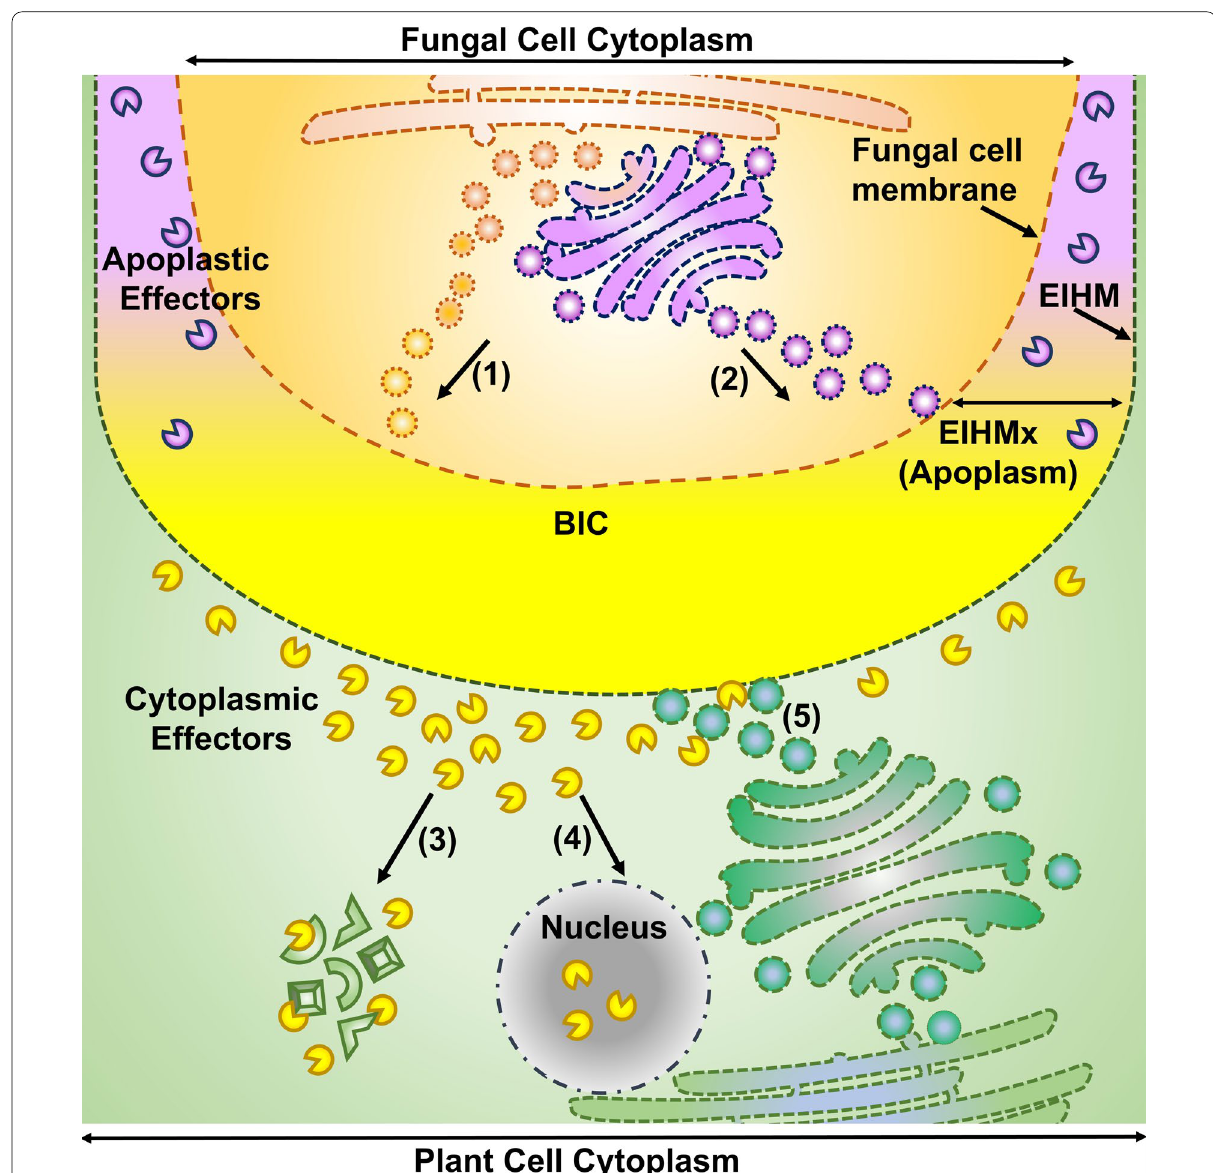
Fig. 3 Effector secretory routes of M. oryzae . The fungal effector secretion takes place via vesicles and follows two routes. The BFA-insensitive vesicle secretion from endoplasmic reticulum (ER) which forms the BIC (1), which is destined for the plant cell cytoplasm, and the BFA-sensitive effector secretion, via Golgi apparatus, which is directed to the EIHMx (2). The effectors secreted to the EIHMx are the apoplastic effectors (violet pie shapes) and secretions from BIC are the cytoplasmic effectors (yellow pie shapes). The cytoplasmic effectors further localise to specific cell compartments such as the nucleus or plasmodesmata (3) or bind their target proteins (4), or have enzymatic activity, to compromise the plant cell and enable fungal growth. The plant cell cytoplasm is shown in green, bright yellow region represents BIC and BIC along with violet represents EIHMx